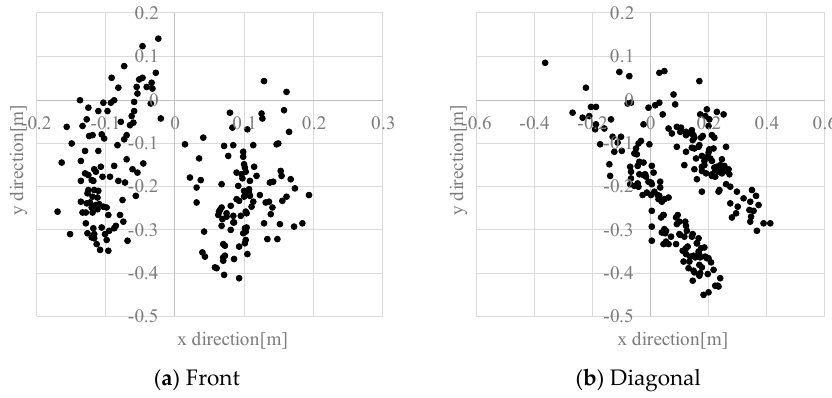
Figure 16. Example of the dynamic hazardous object detection.